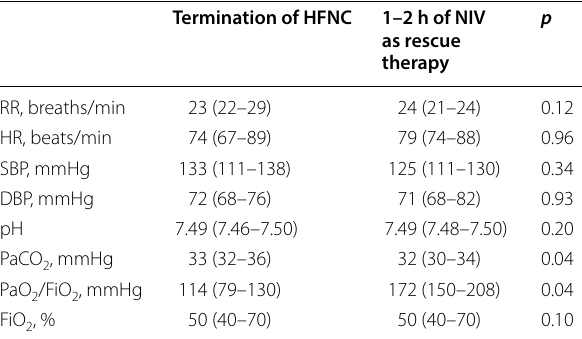
Table 3 Vital signs and arterial blood gas